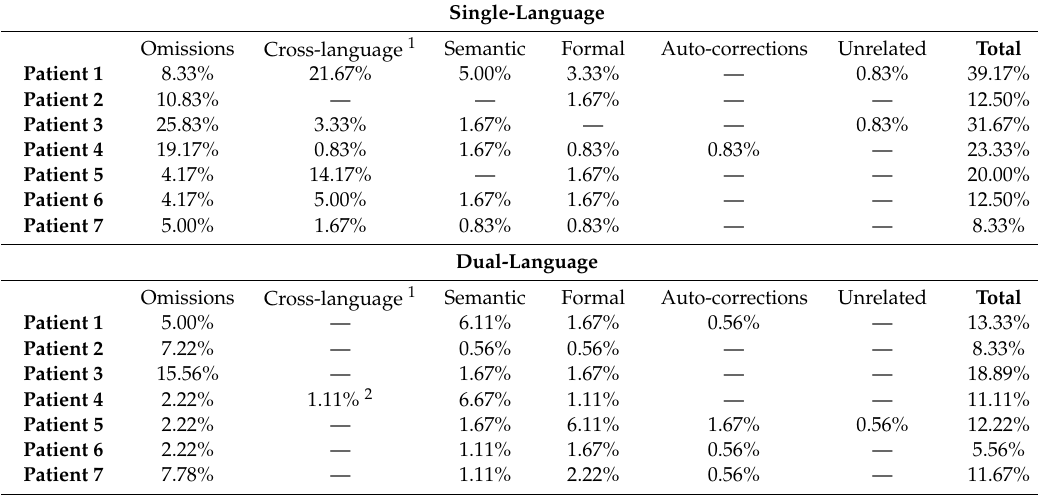
Table 5. Individual error distribution for BWAs in single- and dual-language conditions. Error types expressed as percentage of overall number of condition